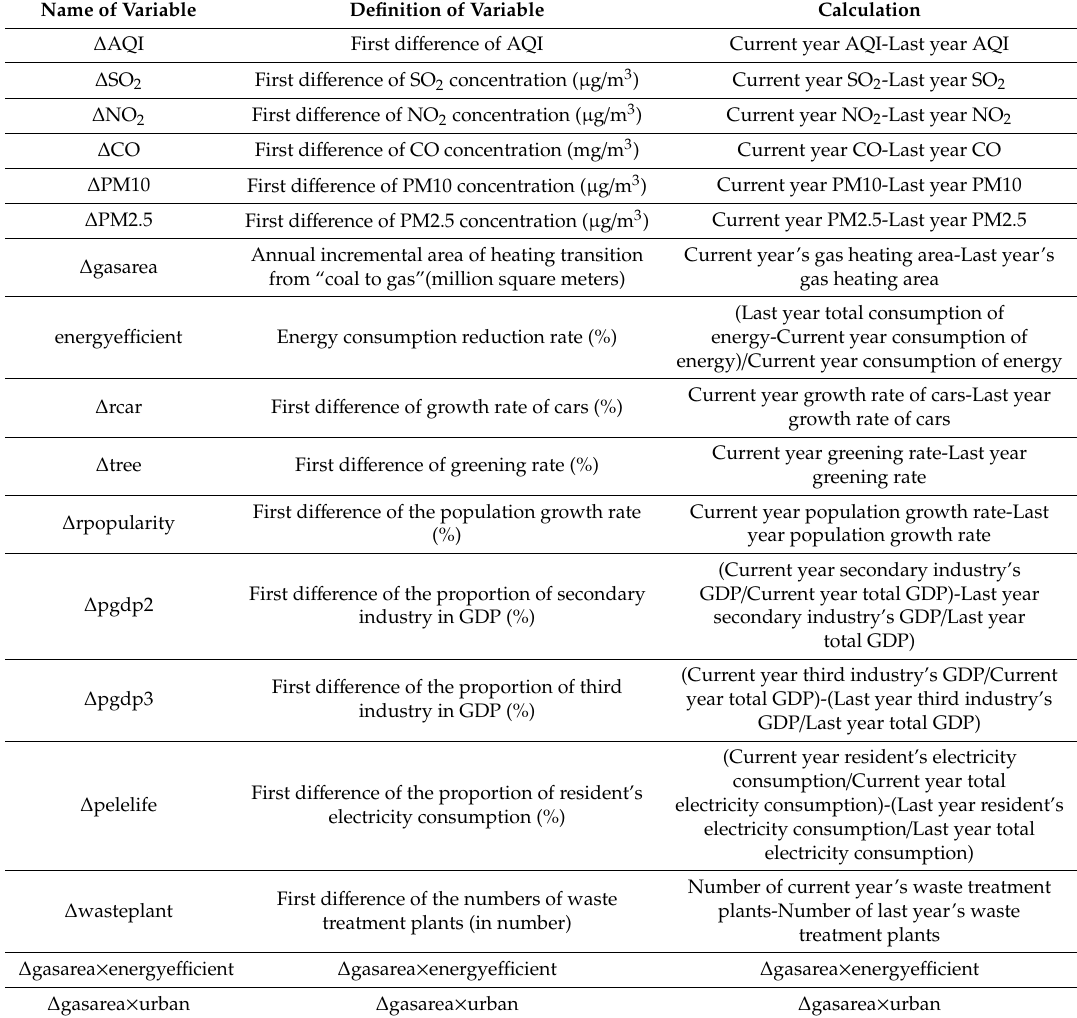
Table 1. Major variables and